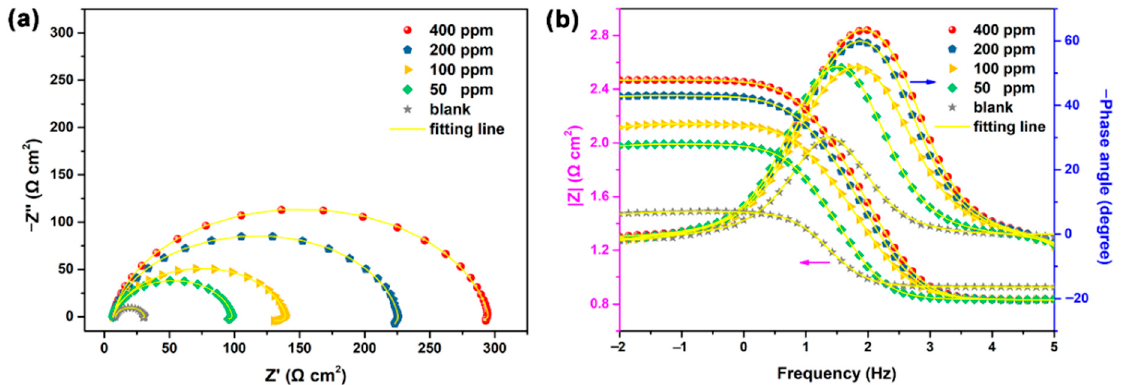
Figure 17. EIS findings of Q235 CS in 1 M HCl medium in the exclusion and inclusion of various dosages of NCDs: ( a ) Nyquist graph and ( b ) Bode graph. Reprinted with permission from Ref. [90]. MDPI (2021).